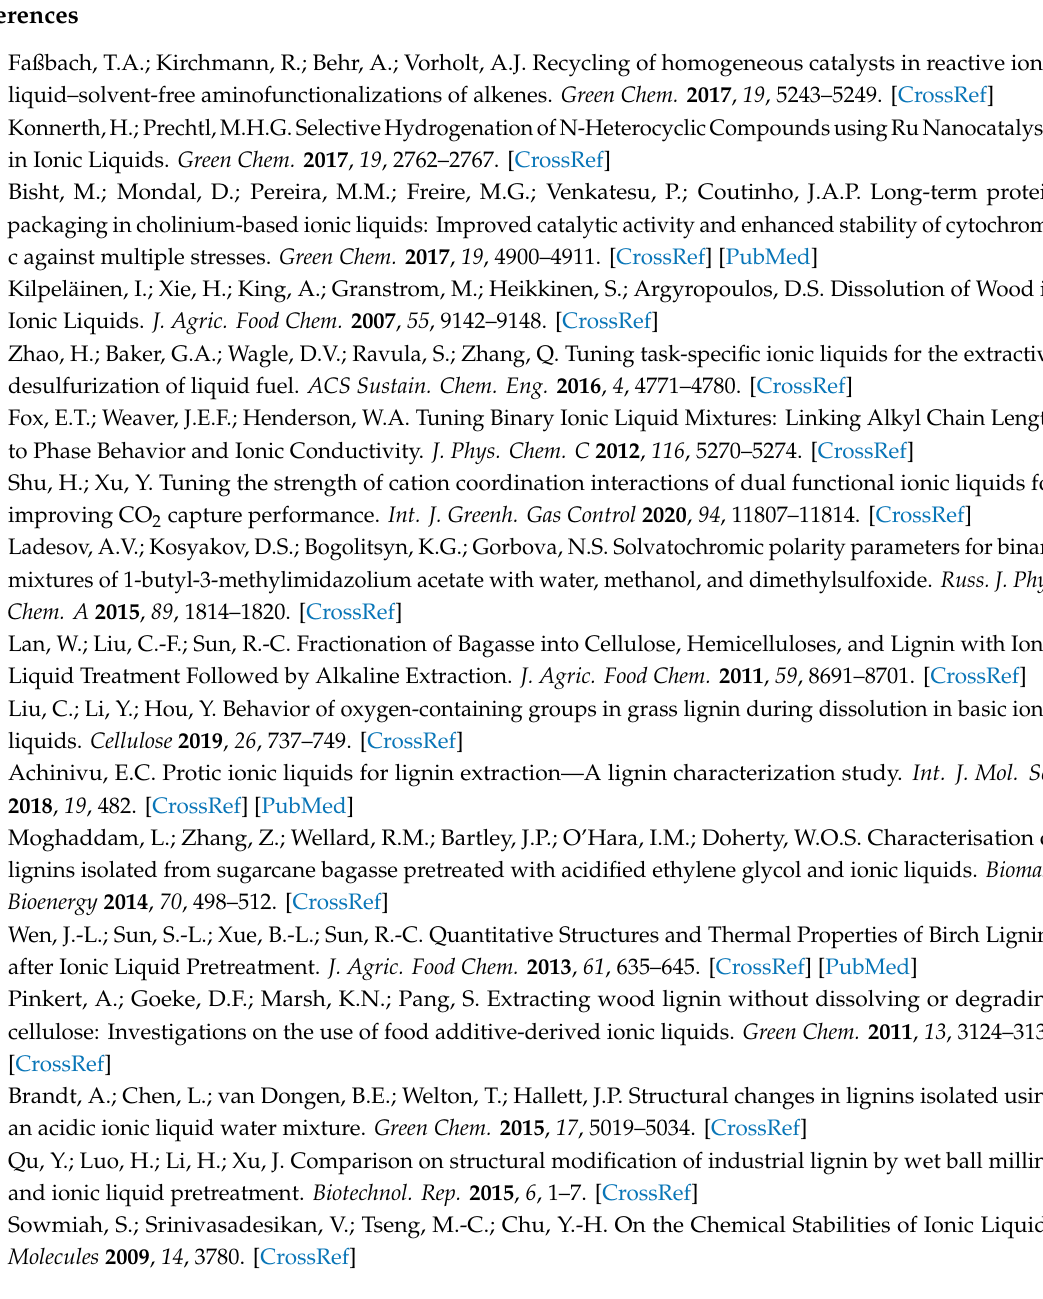
(HSQC) of spruce dioxane lignin, Figure S3: High-resolution (Orbitrap) APPI mass spectra of IL lignins obtained with [bmim]OAc (A), [bmim]OAc-DMSO (B), [bmim]MeSO 4 (C), [bmim]MeSO 4 -DMSO